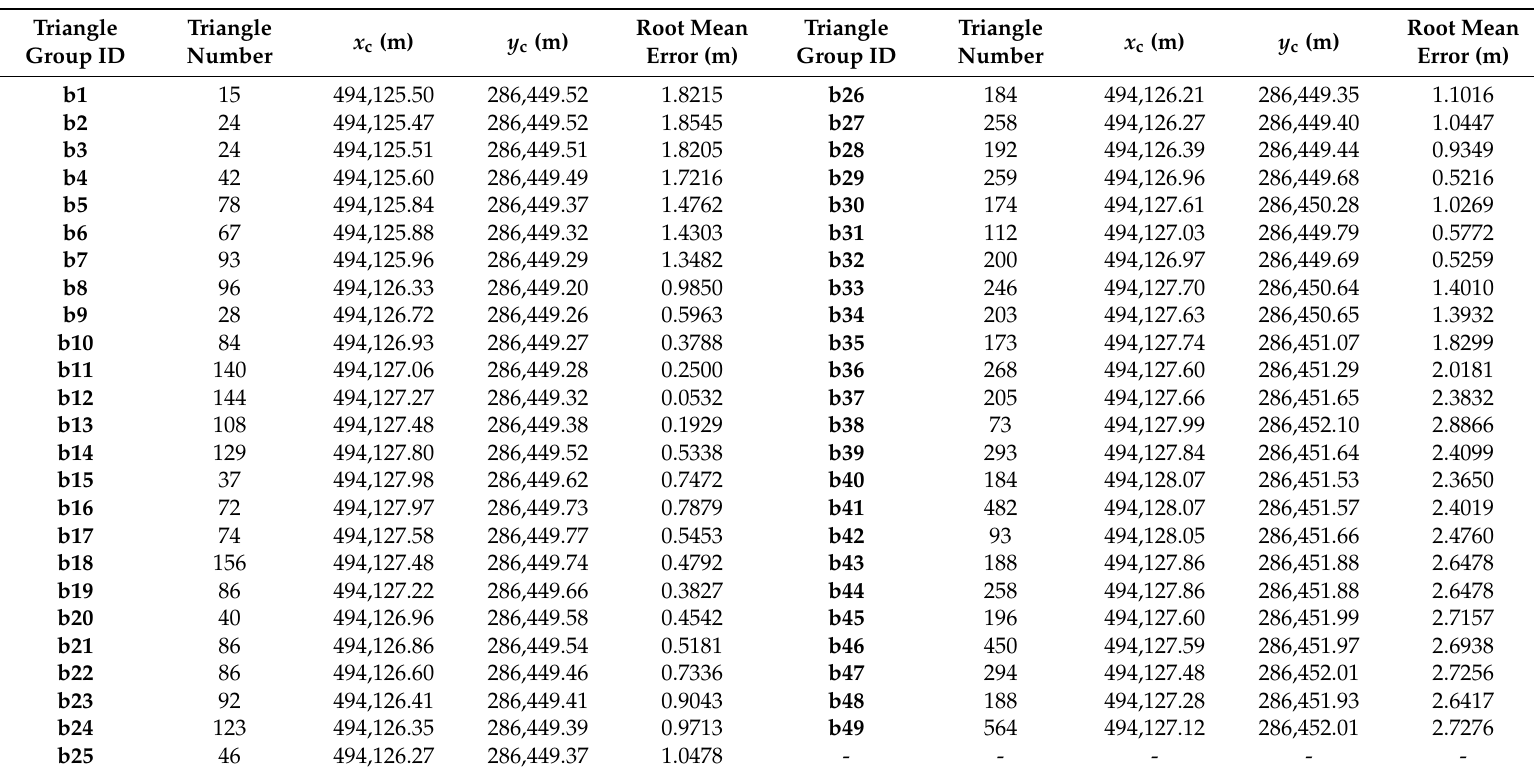
Table 1. The result of the experiment (where x c and y c denote the coordinates of this paper, for the concise description of the table, the digital prefix number is shown in the table